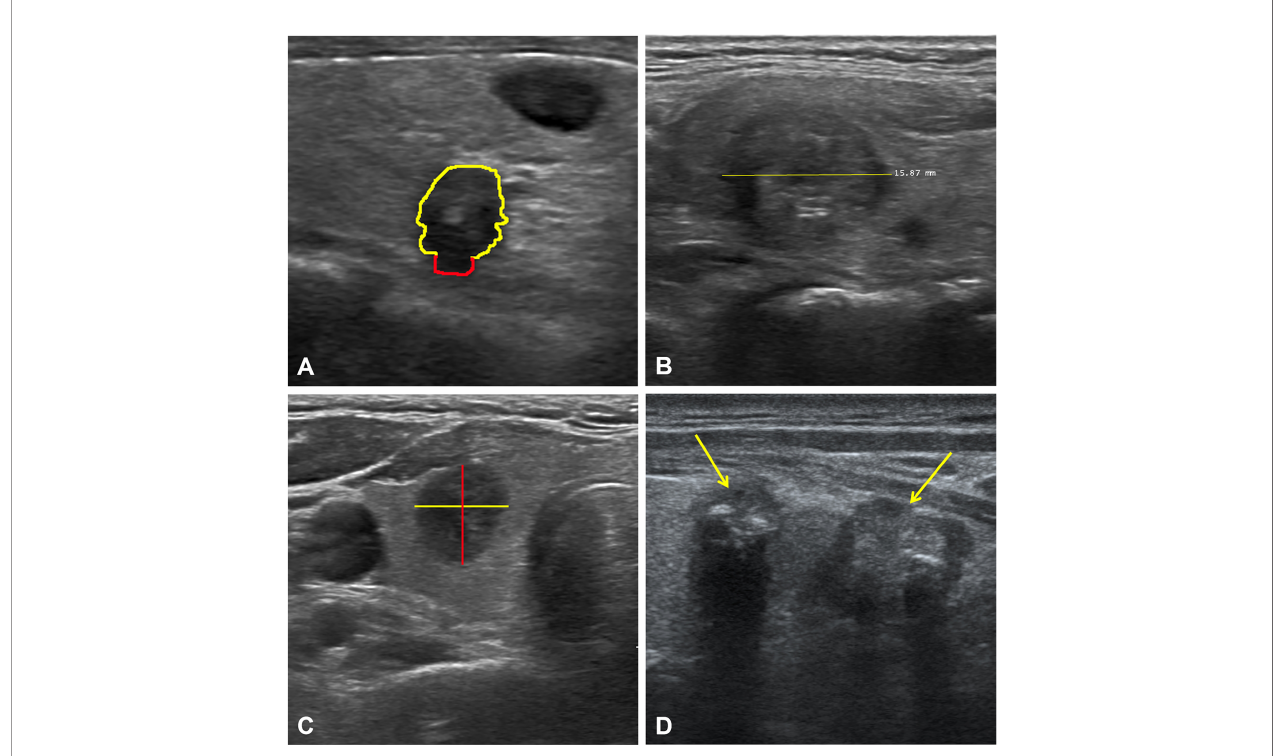
FIGURE 5 | Ultrasound images of four representative cases. Case 1 (A) : The nodule with extrathyroidal extension (red line). Case 2 (B) : A solid nodule with a diameter of 1.6 cm. Case 3 (C) : A hypoechoic nodule with taller-than-wide. Case 4 (D) : Multifocality in the left lobe of the thyroid (yellow arrows). Together, all these features were the most essential factors in the diagnostic performance of the RF algorithm based on ultrasound features. RF, random